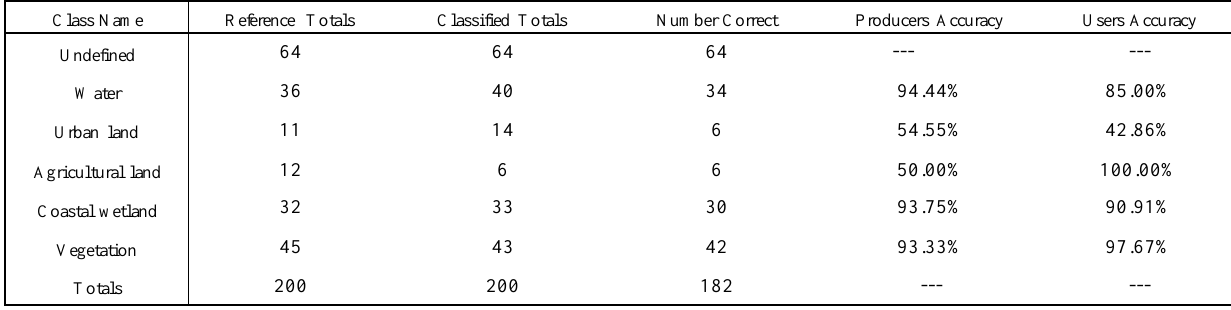
Table 8. Accuracy Evaluation of DT